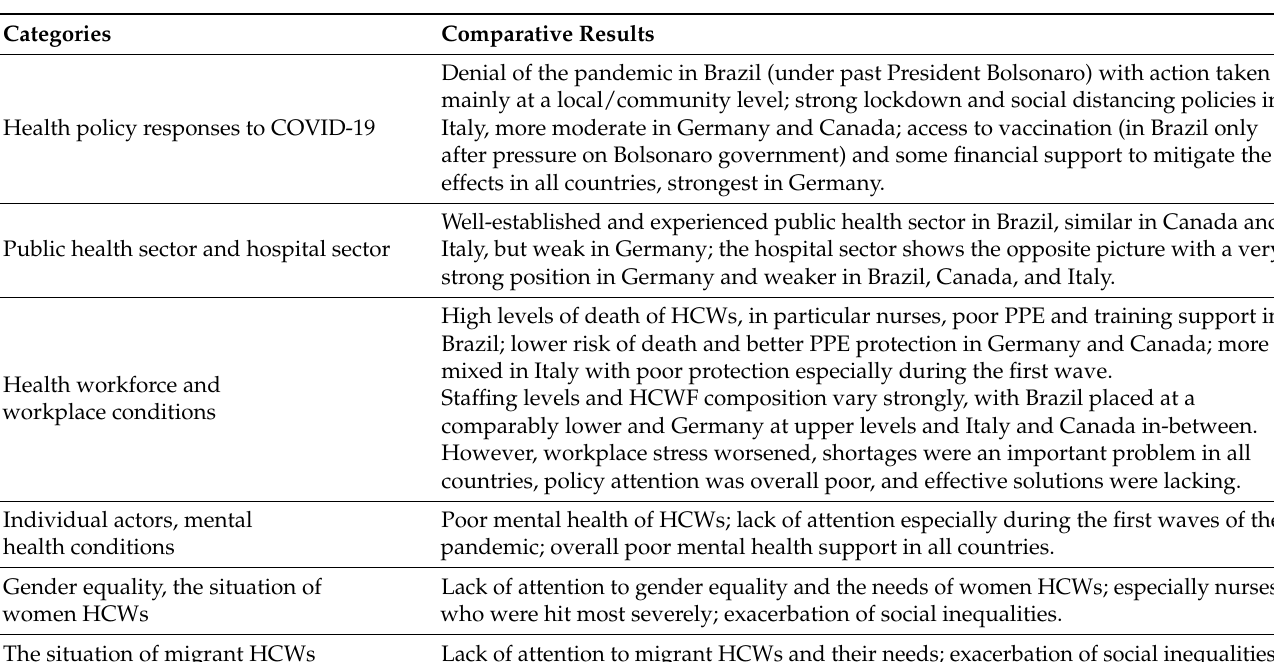
Table 3. A cross-country comparative overview of major